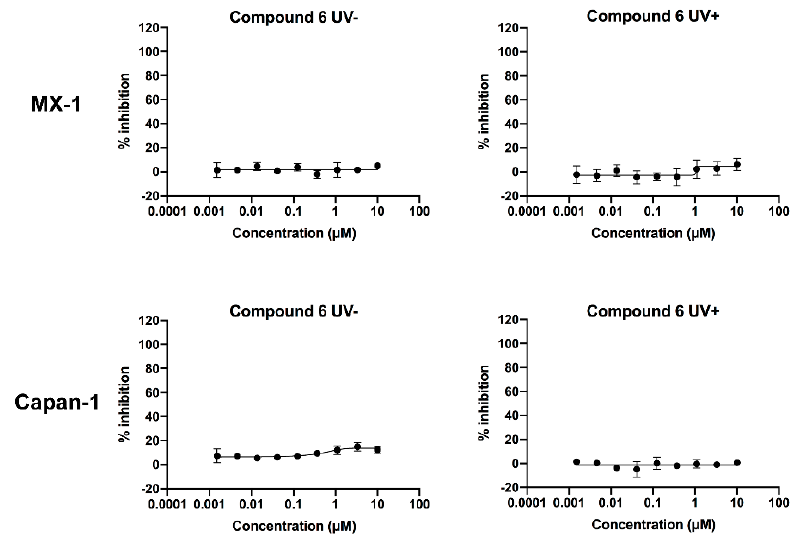
Figure 7. Dose–response curves of compound 6 in the absence and presence of ultraviolet radiation in the MX-1 and Capan-1 cells. After 20 min of irradiation at 365 nm (4.1 mW/cm 2 ), the compounds were transferred to 96-well plates and incubated with the cells. Cell growth was determined 10 days after incubation with the compounds. Irradiated compounds showed similar dose–response curves as that of unirradiated compounds. Error bars represent standard deviation from duplicate determinations, and results are shown as mean ± SD. The IC 50 value is presented in Table